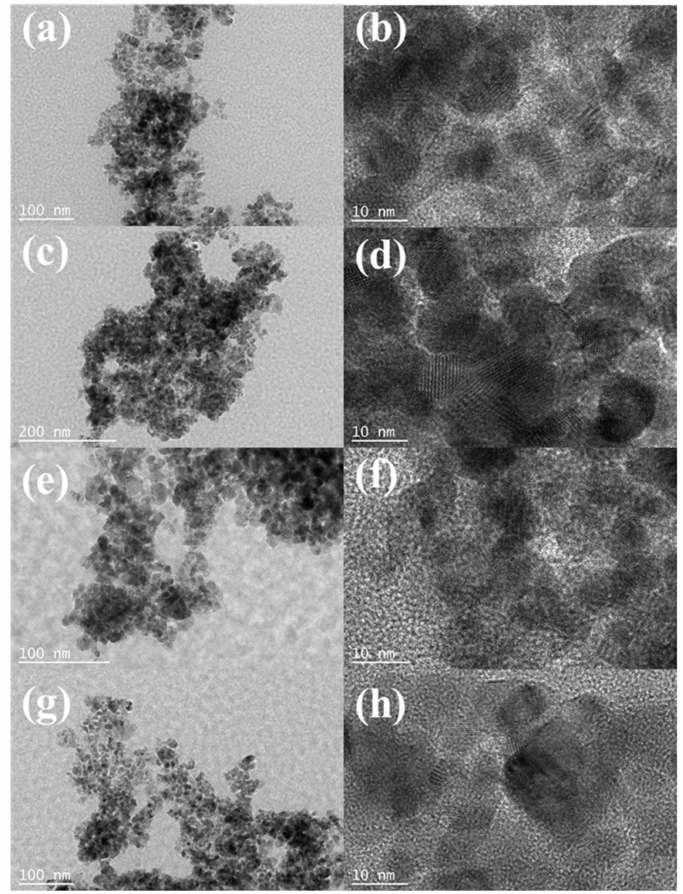
Figure 3. Transmission electron microscopy (TEM) images of the 15Ni2R/M-Ce80Zr20 (R = La, Sm, Pr, Yb) catalysts: ( a , b ) 15Ni2La/M-Ce80Zr20, ( c , d ) 15Ni2Sm/M-Ce80Zr20, ( e , f ) 15Ni2Yb/M-Ce80Zr20,